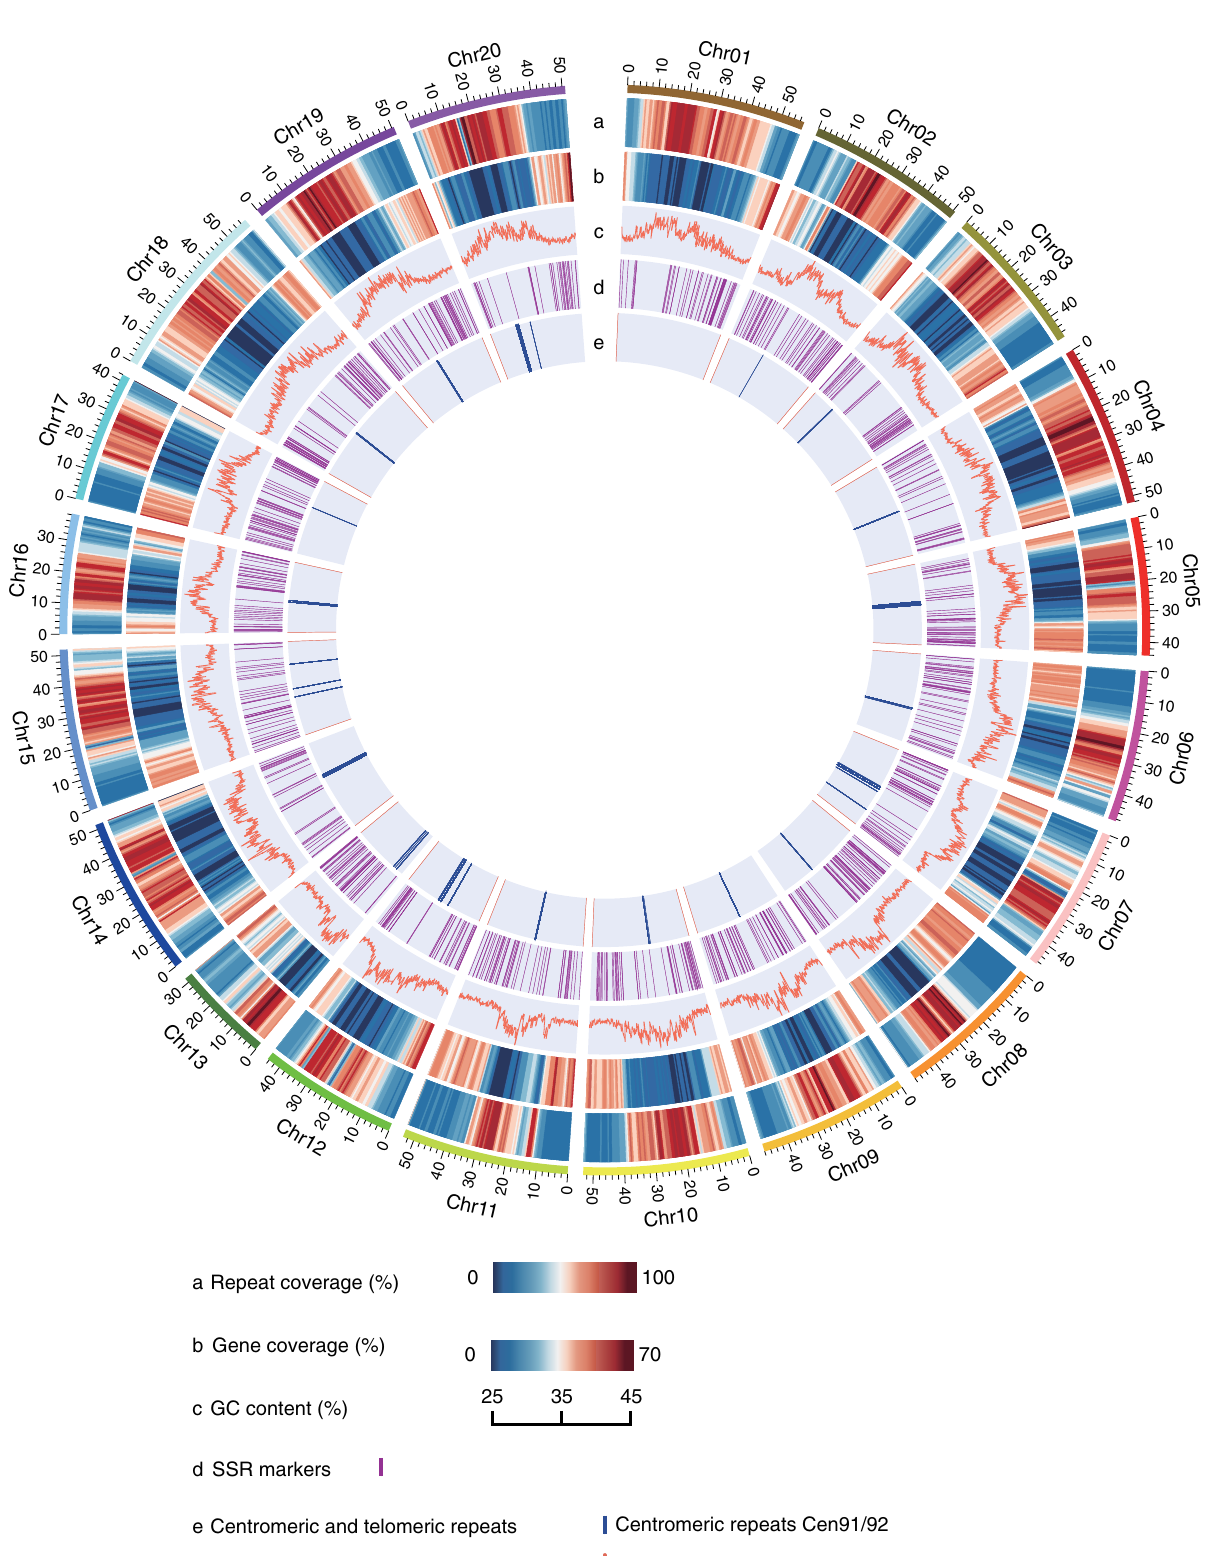
Fig. 1 Distribution of W05 genomic features. The outer layer illustrates the 20 chromosomes of W05 in megabases (Mb). a Repeat coverage was calculated by the occupancy of repeat sequence in 1 Mb window (step size: 500 Kb). b Gene coverage was calculated by the occupancy of coding sequence in 1 Mb window (step size: 500 Kb). c GC content was calculated in a 200 Kb window. d Position of simple sequence repeat (SSR) markers were indicated in purple. Marker information could be found in Supplementary Data 1. e Presence of telomeric tandem arrays and cent91/92 soybean speci fi c type centromeric repeats were marked in pink and blue,